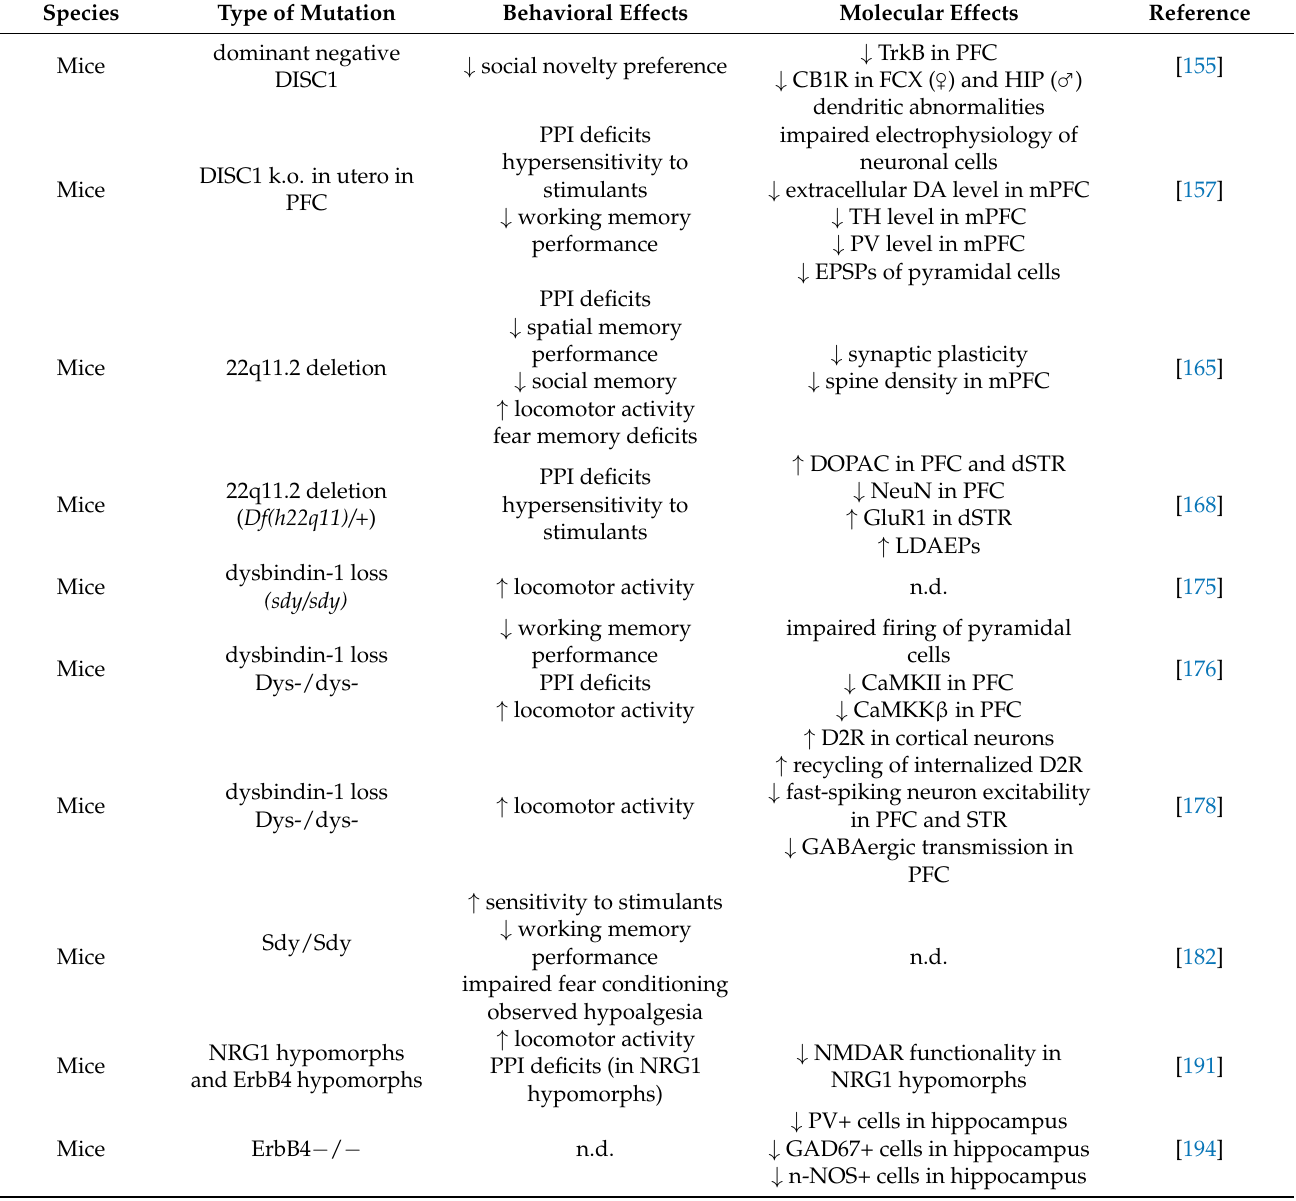
Table 2. Several examples of genetic mutations used to model schizophrenia and its behavioral and molecular